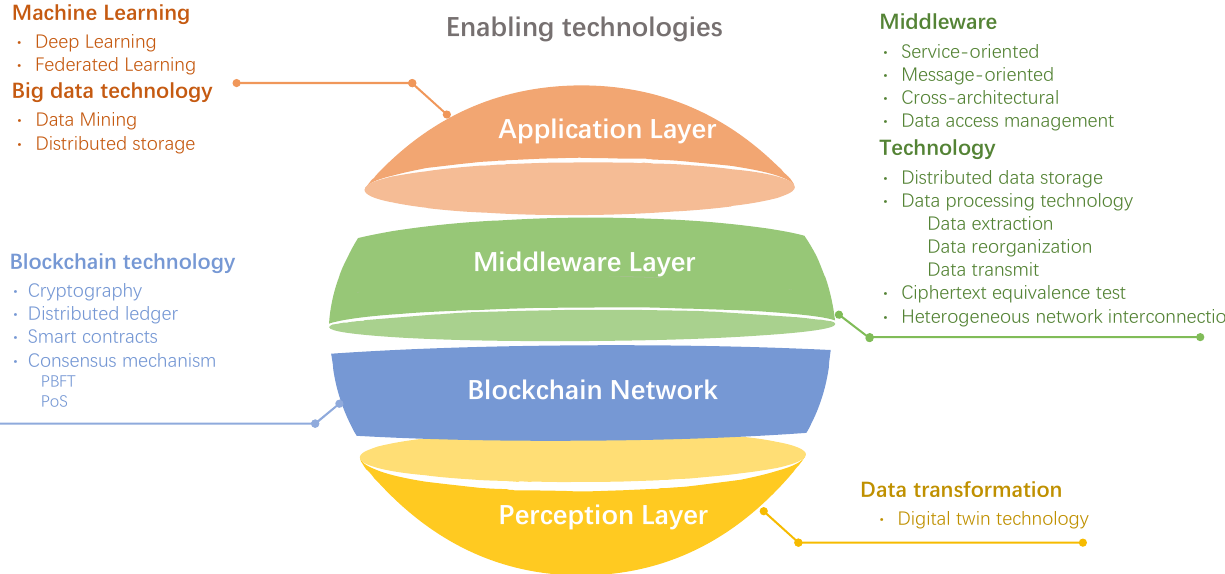
Figure 5. Key enabling technologies in blockchain middleware for IIoT.